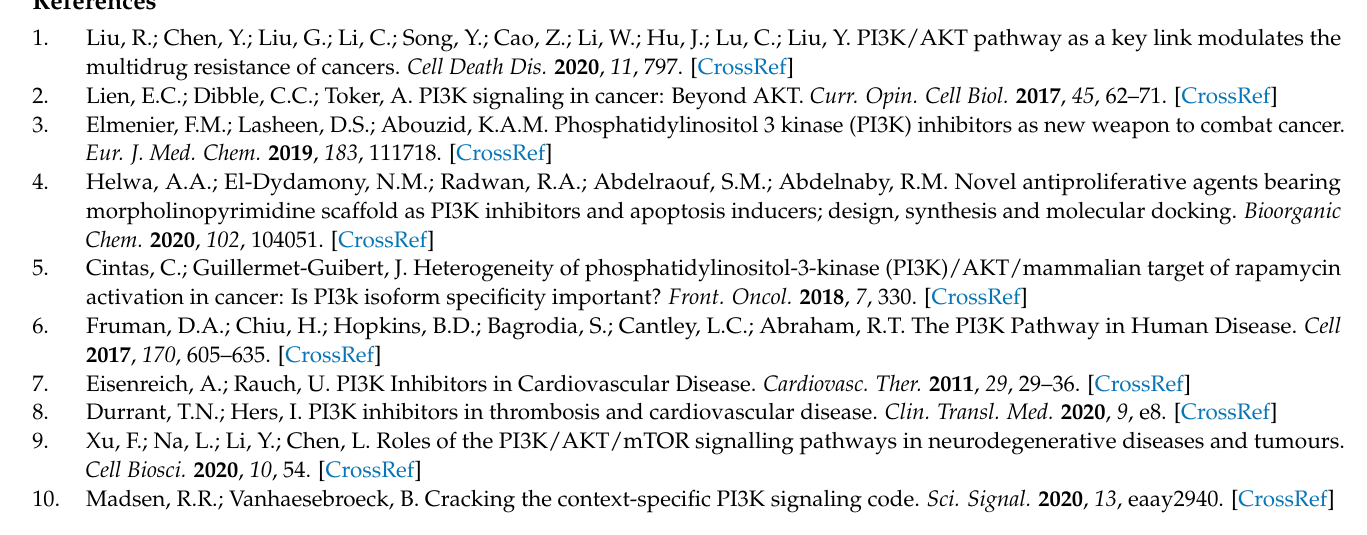
study, Table S3: General procedure for the synthesis of starting reagents 23 , Table S4: 1 H NMR (DMSO- Table S5: MS spectra of representative synthesised inhibitors, Figure S1: Interaction-binding mode of docked ligands in the active site of PI3K α